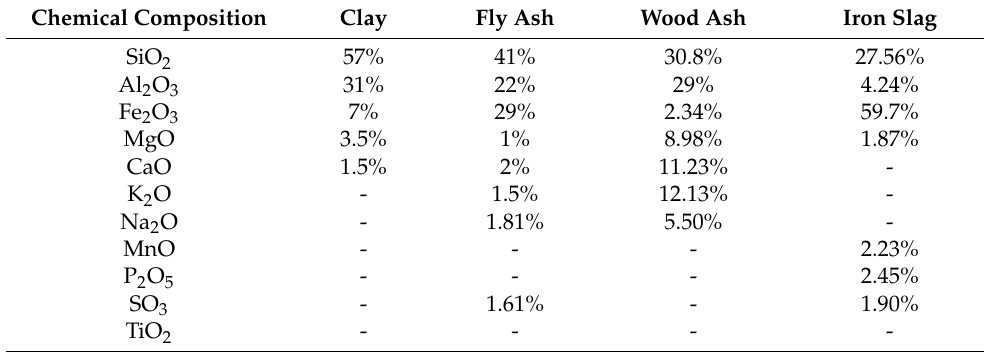
Table 4. Chemical composition of the constituent materials using XRF Analysis.